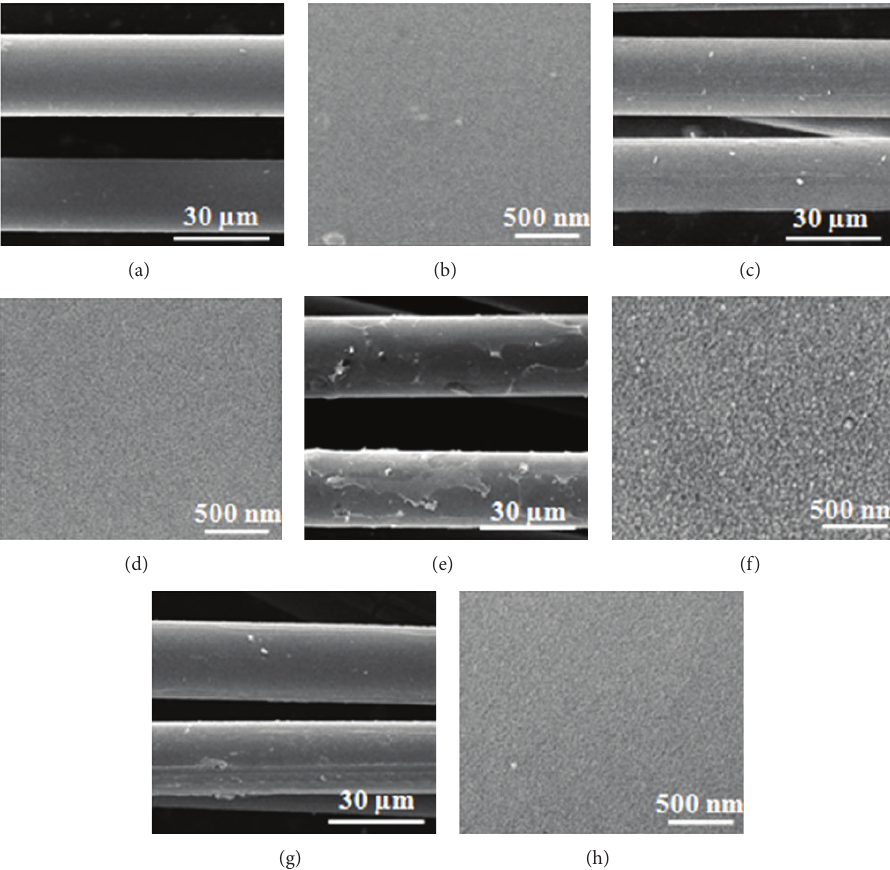
Figure 3: SEM images of glass fibers, some coated and calcined at 600 ∘ C: (a) uncoated 1,500x, (b) uncoated 60,000x, (c) TiO 2 1,500x, (d)